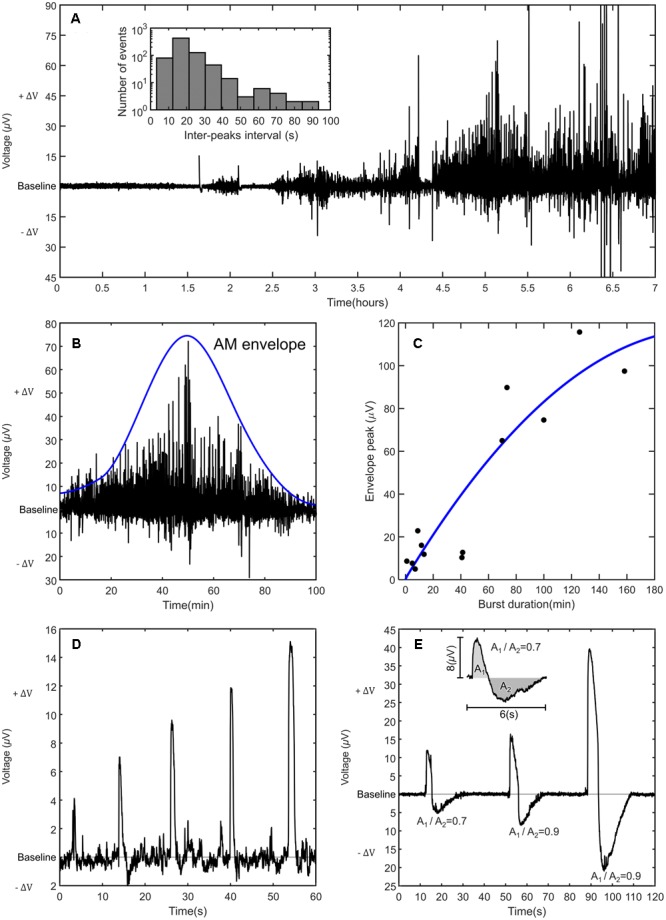
Electrical signals recorded in astrocytes populations. (A) An overview of a long-term recording of astrocyte population activity with different amplitude modulated (AM) bursts of activity. The inset shows a histogram of the inter-spike intervals recorded for the whole burst activity shown in (A). (B) Typical AM modulated burst. (C) Relation between the burst duration and the envelope amplitude. (D) Detailed view of several individual signals. (E) Asymmetric signals with increasing magnitude. As the signal amplitude increases, the ratio between the areas under positive and negative voltage fluctuations becomes 0.9.